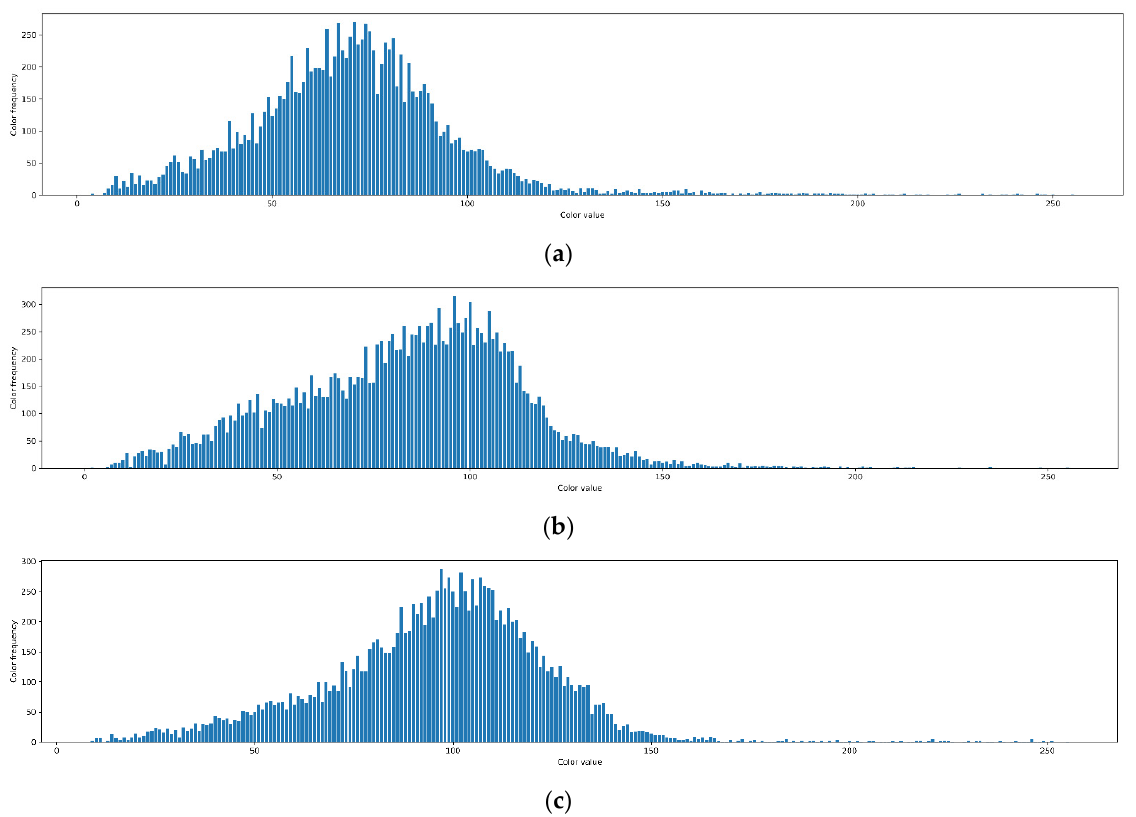
Figure 2. Distribution of b * channel in grape samples of the 7th vine tree: ( a ) sampling day 1; ( b ) sampling day 5; ( c ) sampling day